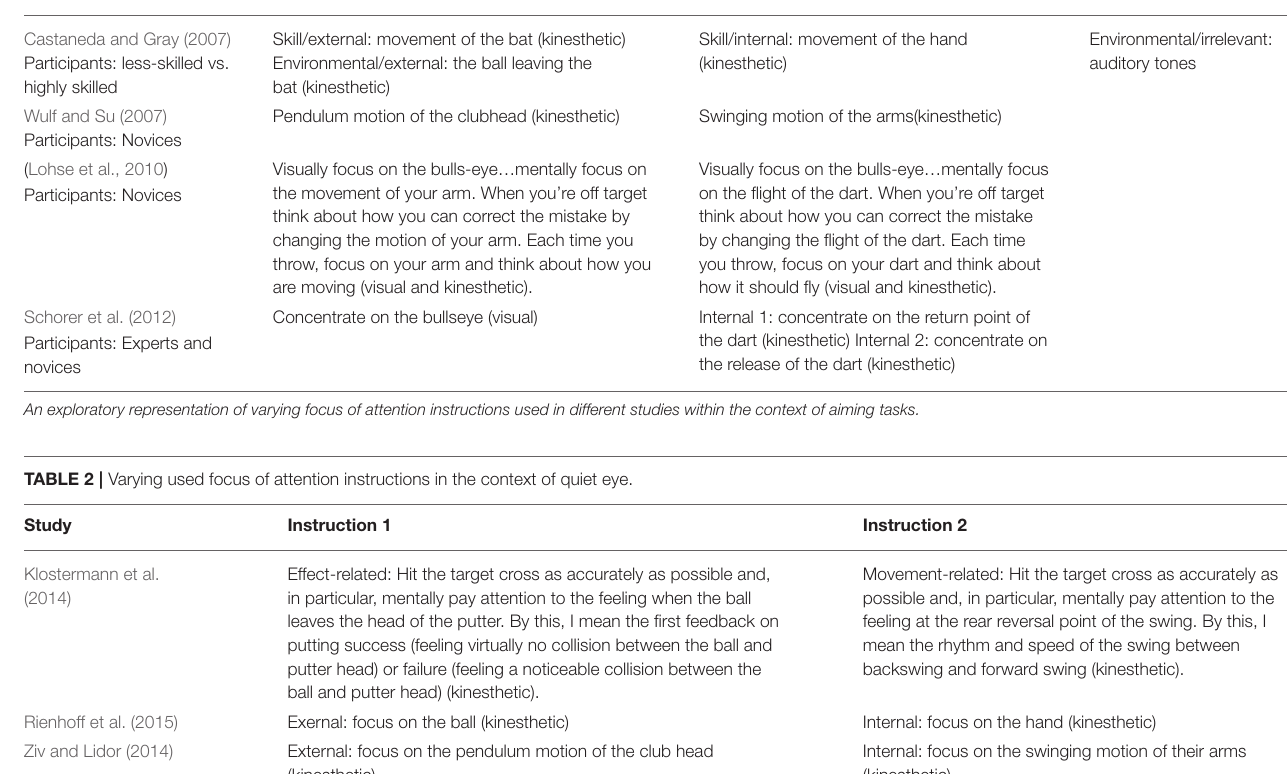
Skill/internal: movement of the hand (kinesthetic)